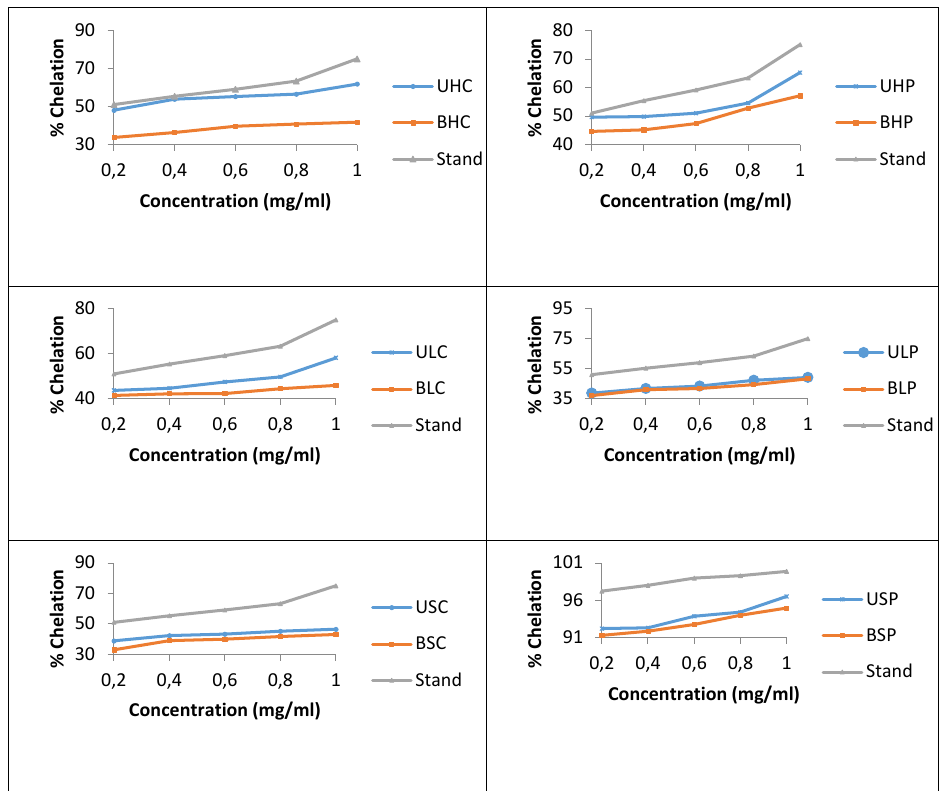
Figure 2: Percentage chelation of cardaba banana and plantain